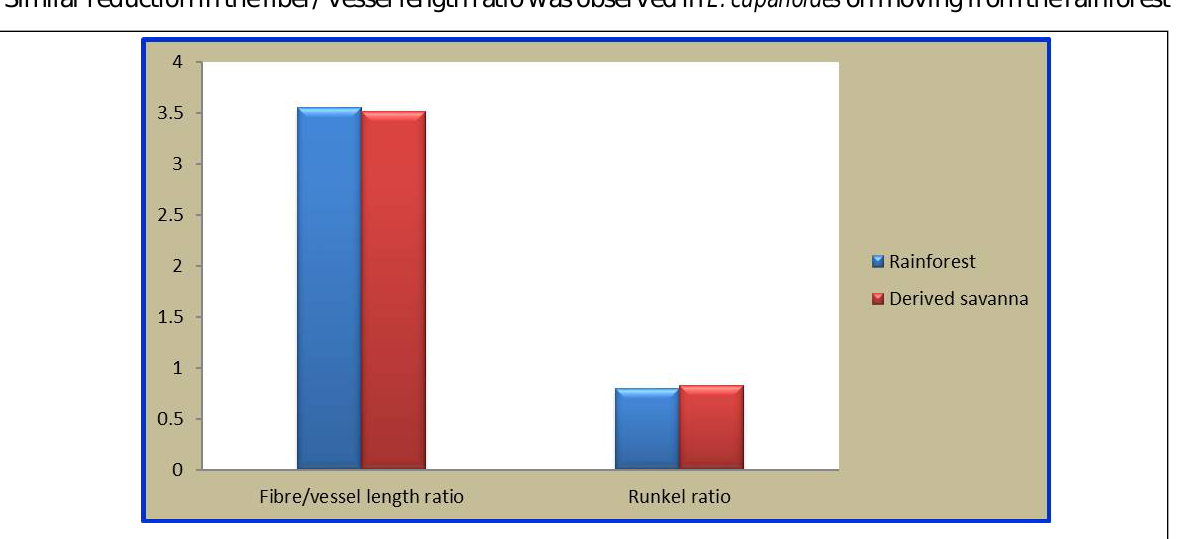
Figure 5: Fiber/vessel length ratio and runkel ratio of B. sapida growing in the rainforest and derived savanna regions of Edo state